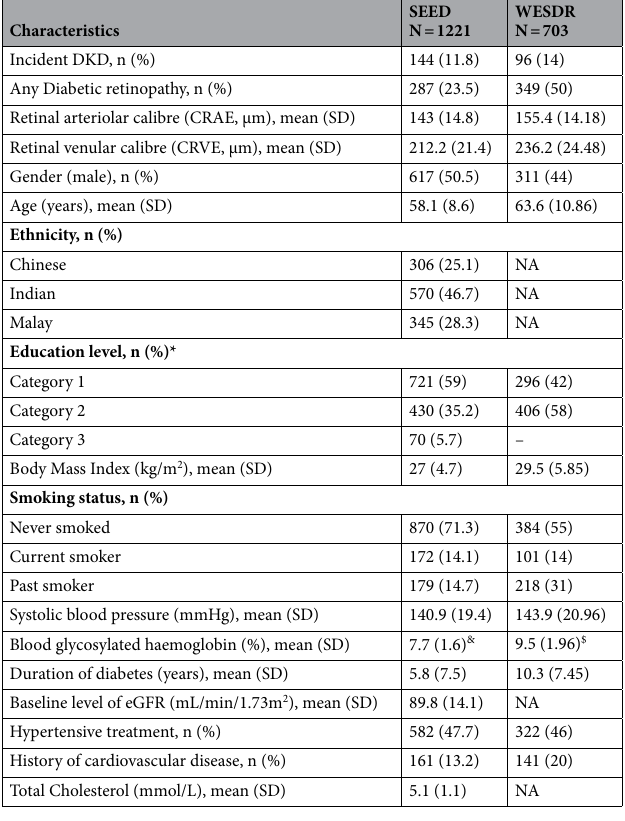
Table 1. Baseline characteristics of SEED and WESDR participants. *WESDR: category 1 = grade 1 up to diploma, category 2 = degree and above; SEED: category 1 = no formal education or primary education